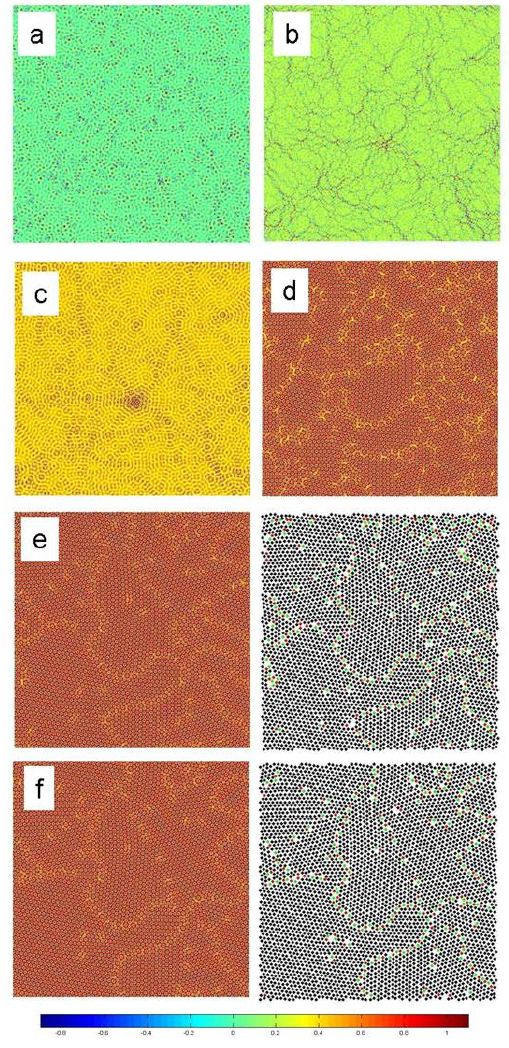
Figure 1: Time evolution of the copolymer system. Simulation data: 1024x1024 grid with spatial dis- cretization ∆ x = 0 . 5 and periodic boundary